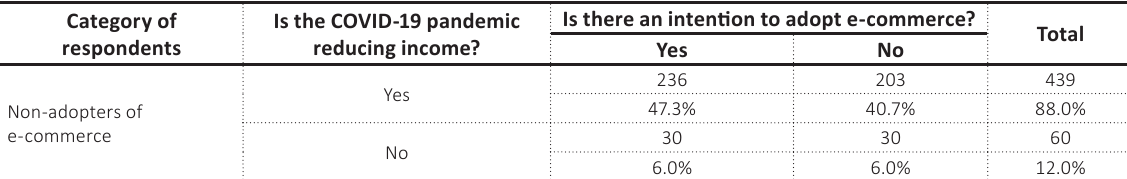
Table 6. Intention to adopt e-commerce